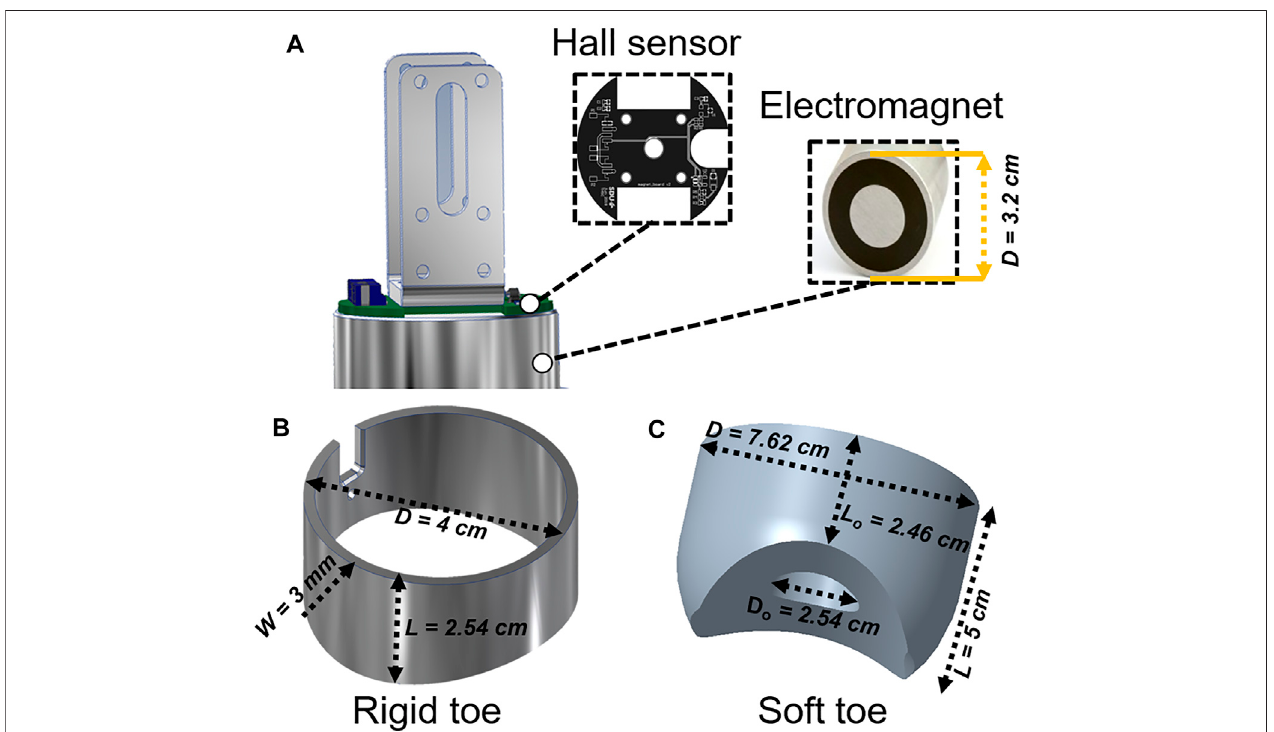
FIGURE2| Therobothastwolegs:eachwithafootasametal-surfaceattachmentmechanism.Therobotfeetareinspiredfromthefunctionalityofaninchworm ’ slegs. (A) Acomputer-aideddesign(CAD) oftherobotfoot,consistingofaHallsensortodistinguish betweenthemetalandnon-metalsurfaces. TheHallsensorprovides0.78 Vif therobotfeetareonametalsurface,and0.94 Vwhenonanon-metalsurface,givingtherobotthecapabilitytodifferentiatebetweenthemetalandnon-metalsurfaces.Italso employsaround fl ux-changingpermanentmagnettoattachanddetachtherobotfrommetalsurfaces. (B) ACADoftherigidtoe,mountedaroundtheelectromagnet. Thetoeisdesignedwithaconcavecurveunderneathittopassivelyadapttoanotherconvex-shapedcurvedsurface(ametalpipeinthiscase).Itisdesignedtobe3Dprinted usingPLAthermoplasticswiththeillustrateddimensions. (C) ACADofthesofttoeinspiredfromthestructureandcompliantnatureofaninchworm ’ slegs.Thesofttoecould wraptheelectromagnetwhileprovidingastableattachmenttoalltypesofroundsurfaces.Usingtheillustrateddimensions(ratios, D o :D and L o :L, aresetapproximatelyas1:3 and 1:2, respectively), the soft toe is designed to be fabricated with silicone elastomer following a mold casting process, as described below.